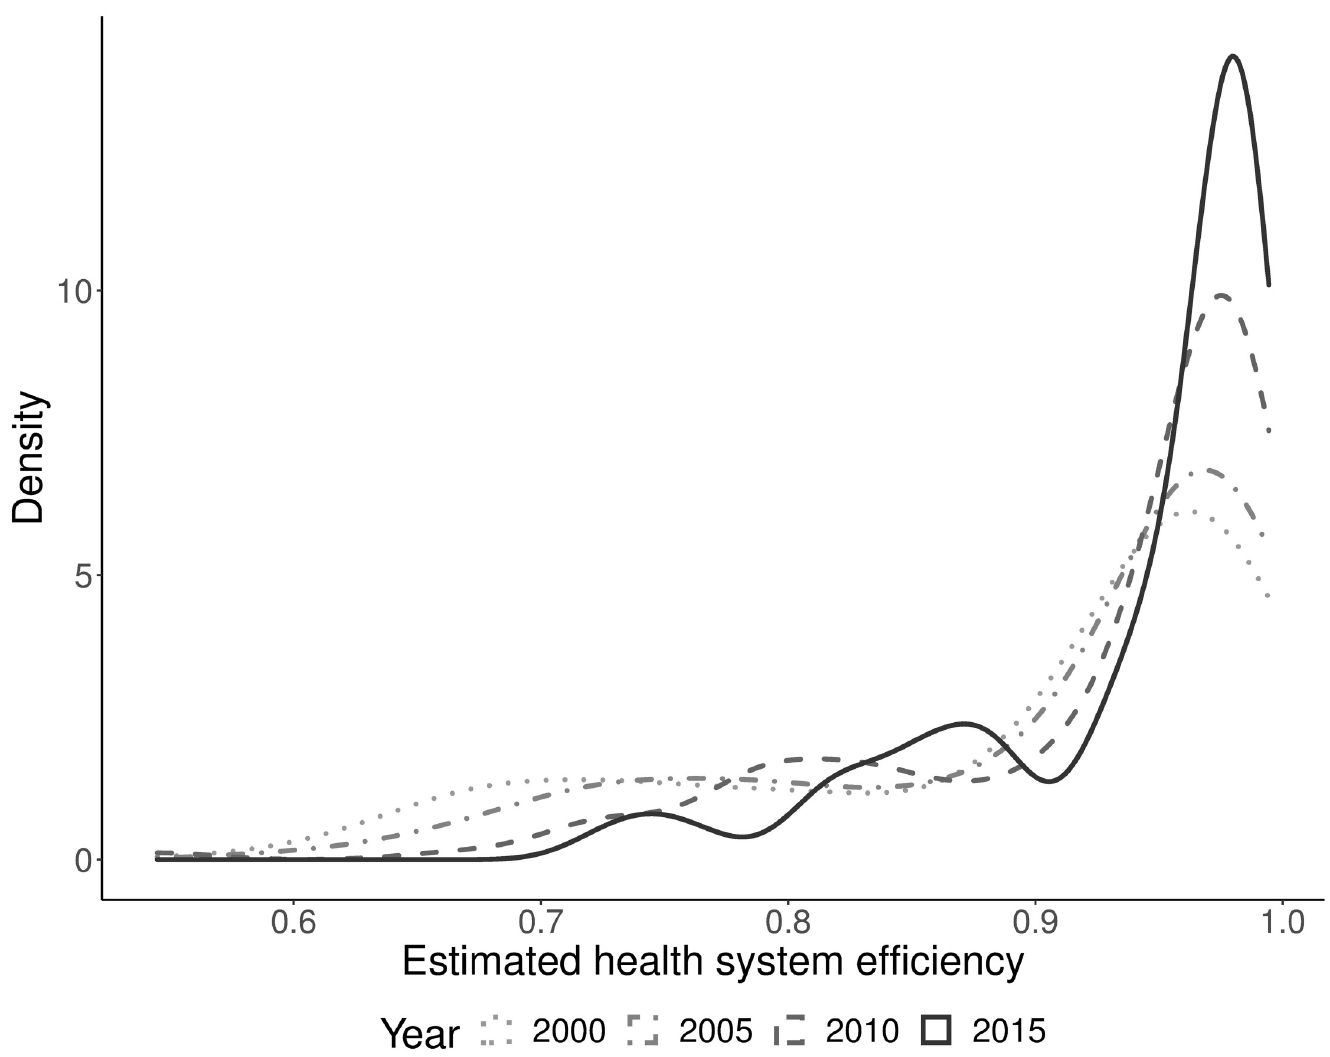
Fig 2. Distribution of estimated health system efficiency of 149 countries over time. Note: To ensure that changes in the distribution of inefficiency estimates over time are not driven by changes in the composition of countries, the depicted data include only countries for which efficiency scores could be derived for all years. The full set of 158 countries was included in estimation of the SFA